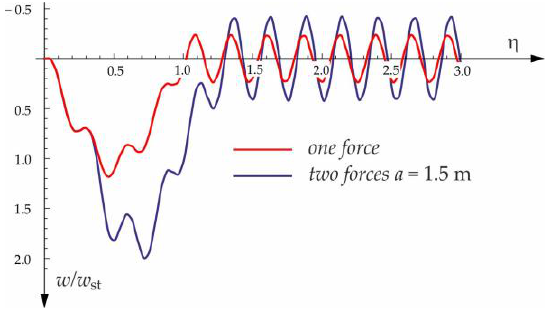
Figure 10. Vibration of midpoint of the beam on three-parameter Vlasov foundation subjected to one force and two forces moving at speed v = 50